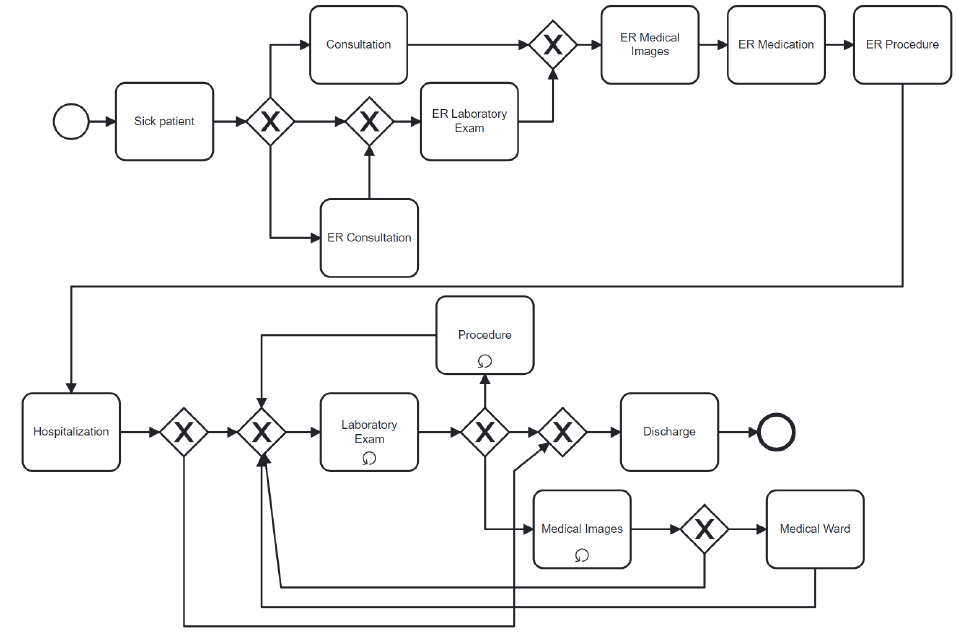
Figure 11. BPMN process model discovered using Split-miner for patient treatment participant.